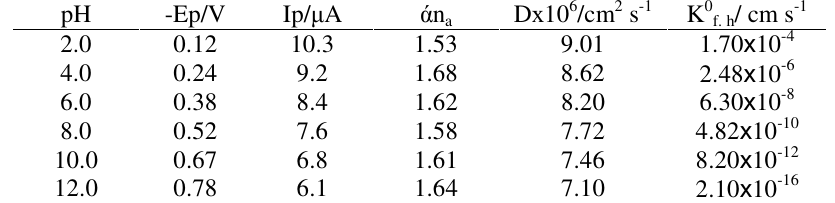
Table 2. Typical cyclic voltmmetric data of fluchloralin concentration 0.5 mM, Scan rate: